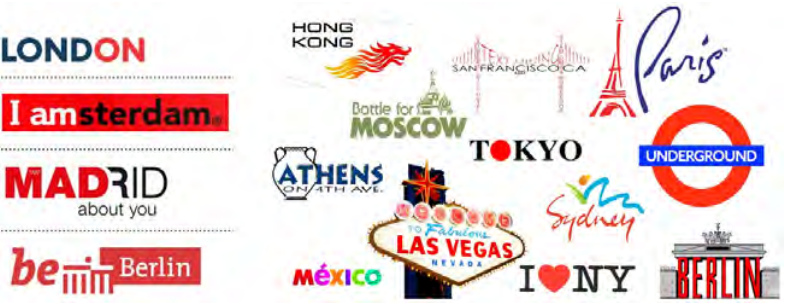
Figure 5. Examples for Cities logos and